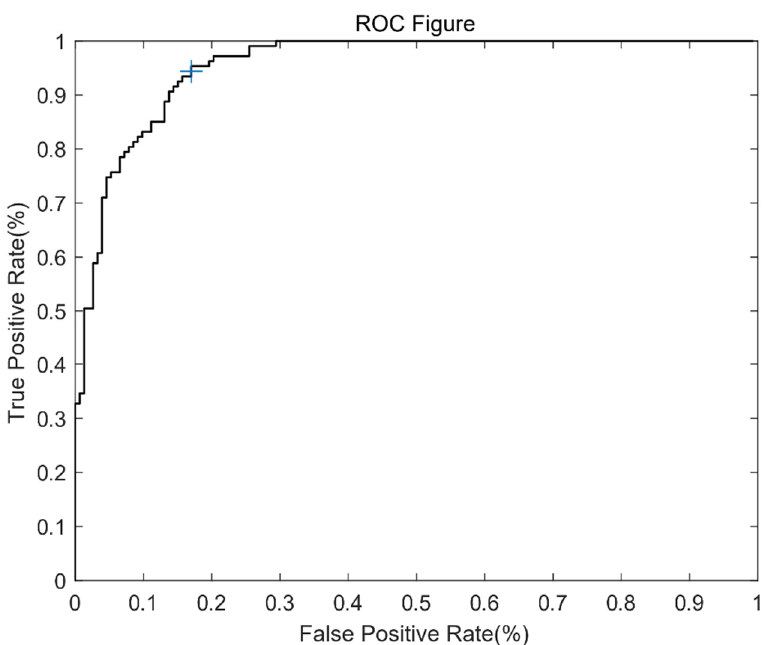
Figure 8. The receiver operating characteristic (ROC) figure for ∆ . The + sign denotes the location of the selected threshold.